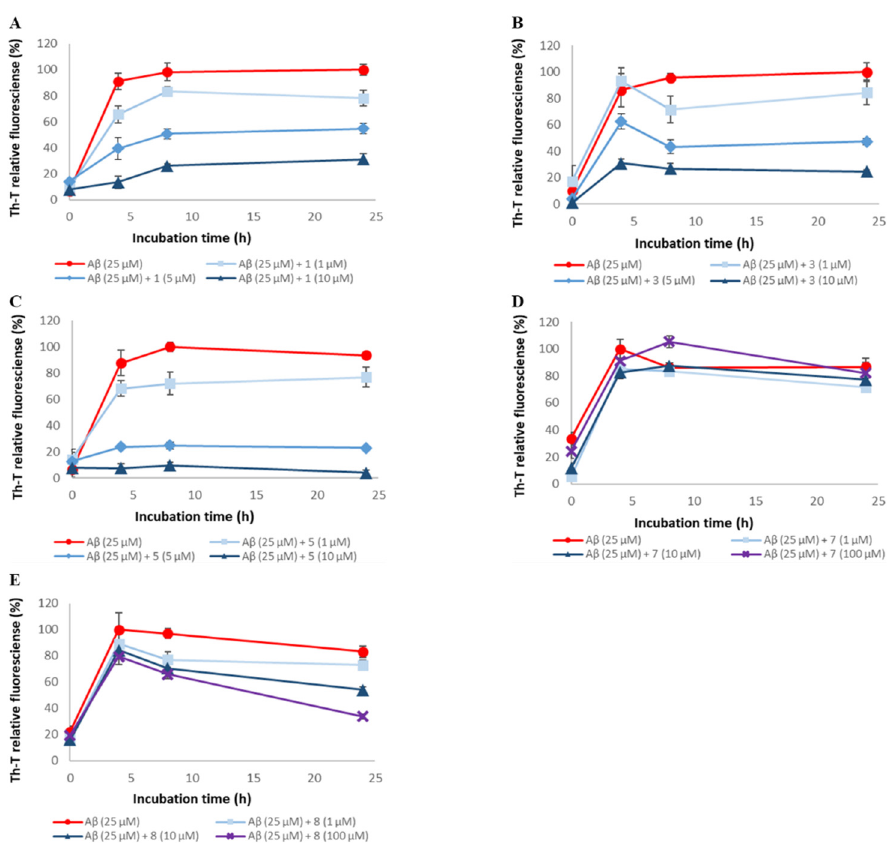
Figure 2. Efficacy of compounds 1 , 3 , 5 , 7 , and 8 against A β 42 aggregation. A β 42 (25 μ M) fibril formation was monitored by Th-T fluorescence with varying concentrations of these compounds. ( A ) 1 , ( B ) 3 , ( C ) 5 , ( D ) 7 , and ( E ) 8 . At an excitation wavelength of 420 nm and an emission wave-